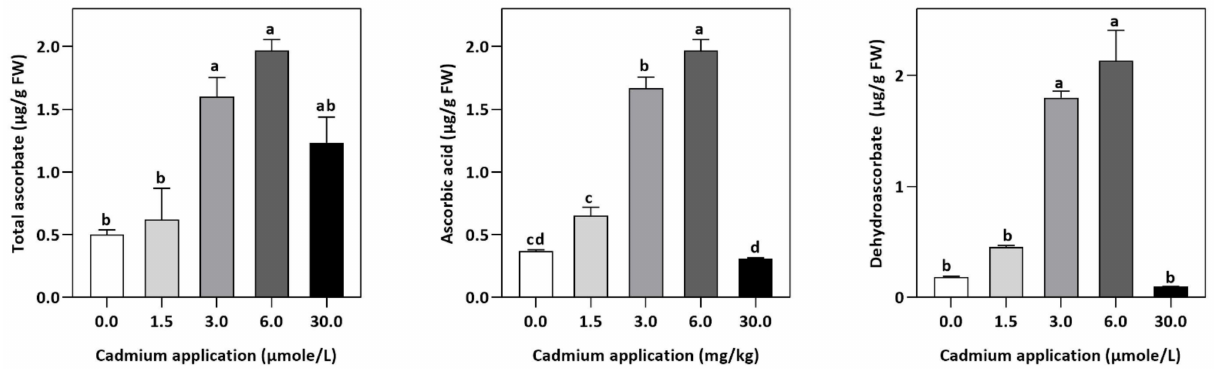
Figure 5. Effect of Cd application on the concentration of TAS, DHA, and ASA E. sativa leaves. Each data value is presented at mean ± SE (n = 5). In Tukey’s multiple range test ( p < 0.05), different letters denote significant differences in